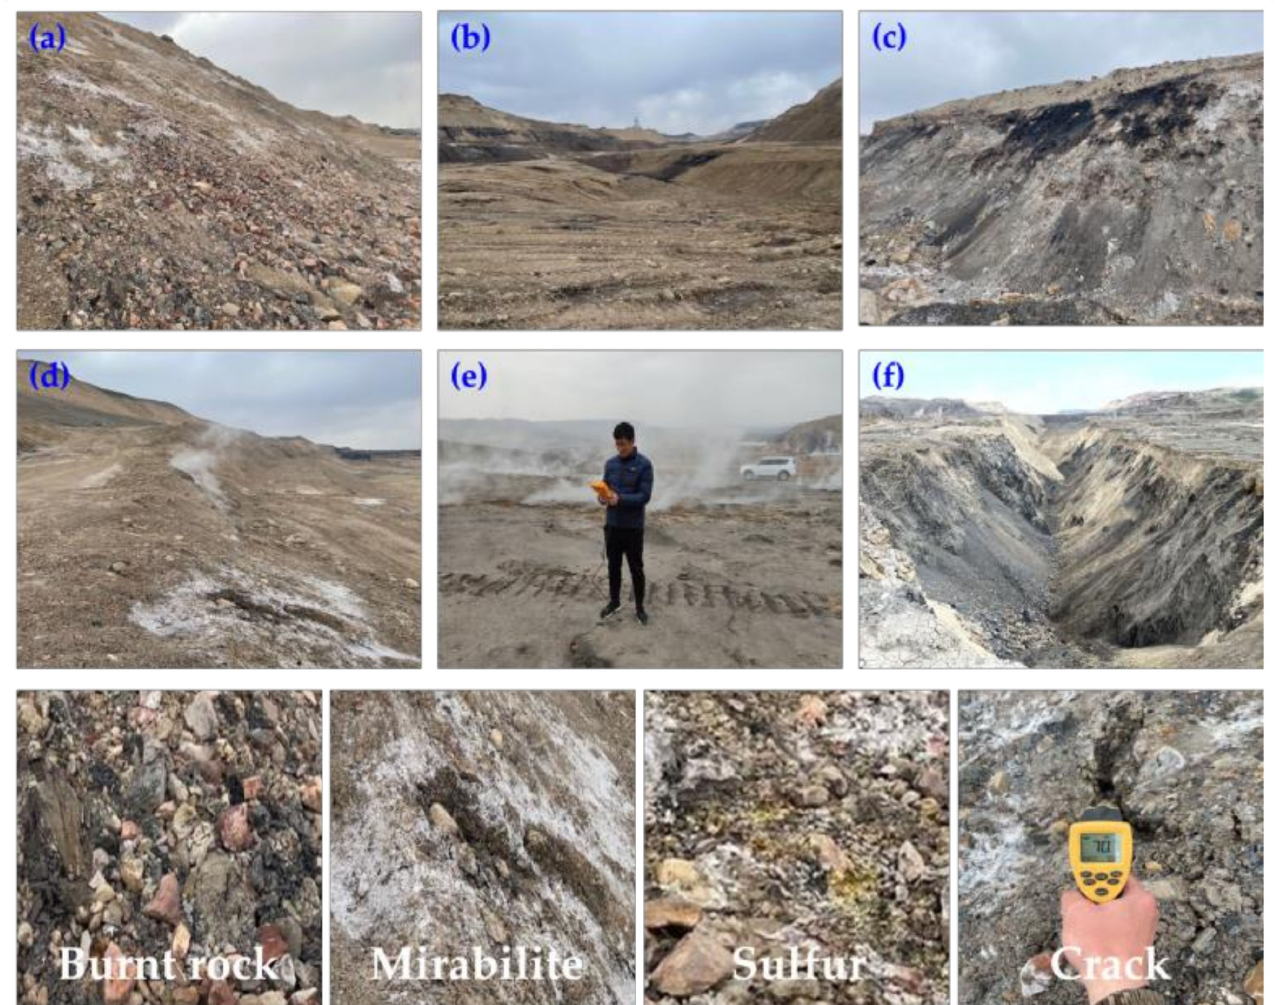
Figure 6. Field verification of satellite extraction results: areas ( a ) 1, ( b ) 2, ( c ) 3, ( d ) 4, ( e ) 5, and ( f )